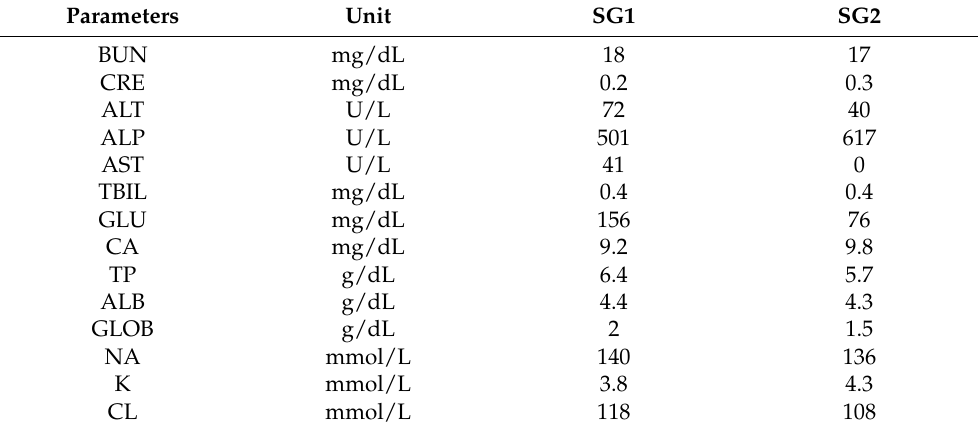
Table A2. Plasma biochemical data of two sugar gliders under one year old.